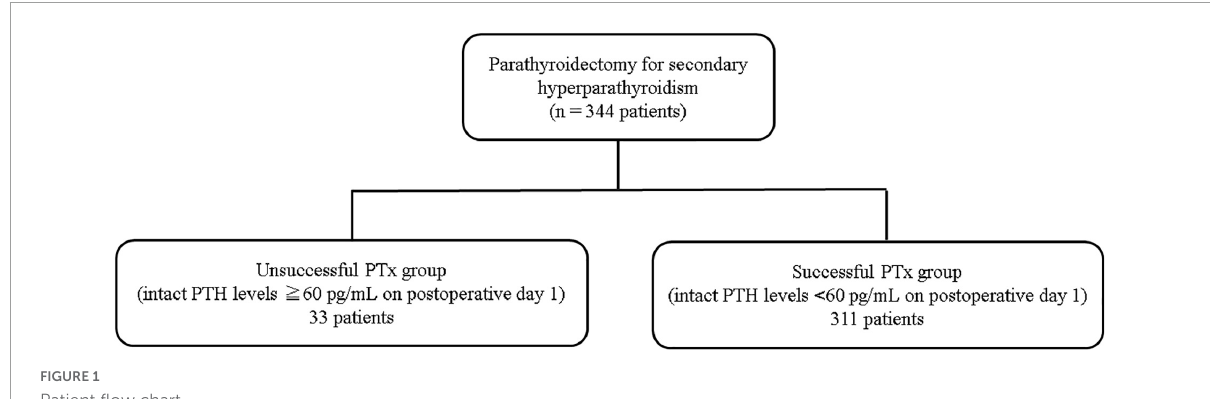
FIGURE1 Patient flow